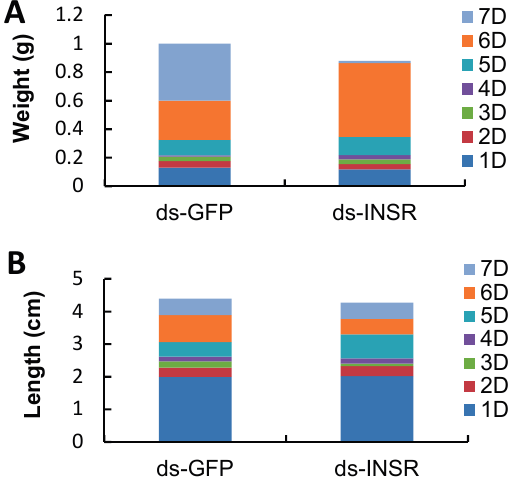
Figure 6. The change of the body length and weight in larvae of different treatments after injection. Ten animals were used in each experiment. Ds-GFP: Group after injection the dsRNA used to silence GFP . ds-INSR: Group after injection the dsRNA used to silence INSR. 1D, 2D, 3D, 4D, 5D, 6D, 7D: One days, two days ,three days ,four days, five days, six days and seven days after injection. ( A ) shows the change of weight of the insect body in 7 days and ( B ) shows the change of length of the insect body in 7 days.